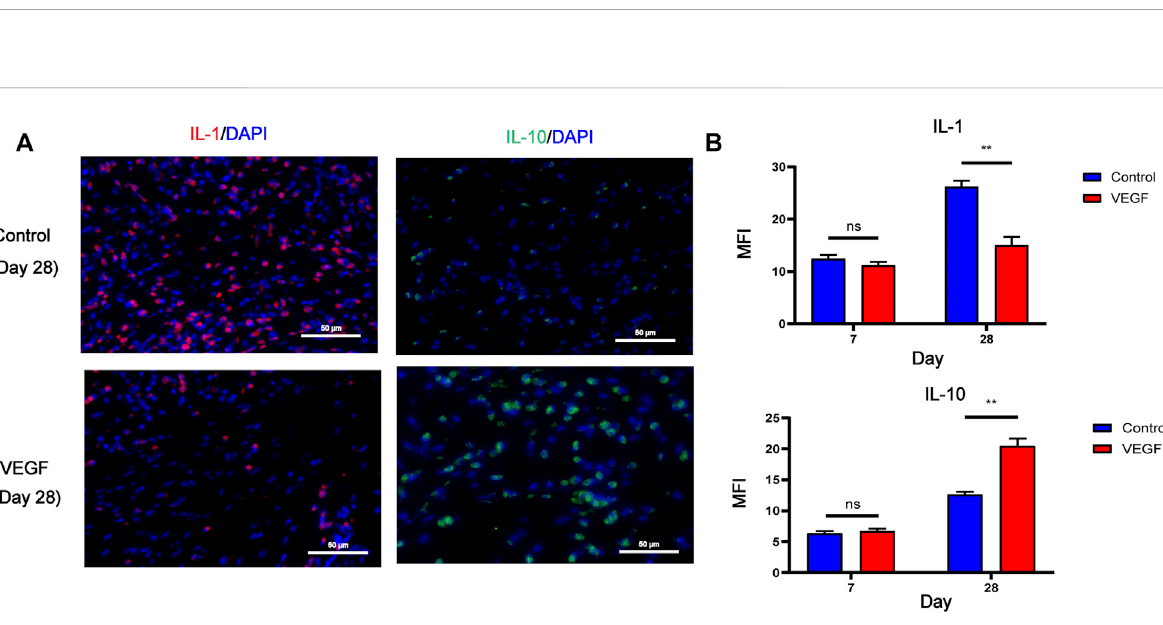
FIGURE 7 Representativeimmuno fl uorescenceimagesofIL-1andIL-10expressionofsubcutaneousimplantsatday28ineachgroup.IL-1stainedinred, IL-10 stained in green (A) . Immuno fl uorescence quanti fi cation of IL-1 and IL-10 (B) . MFI, mean fl uorescence intensity. * p < 0.05. ** p < 0.01. ns represents no signi fi cant